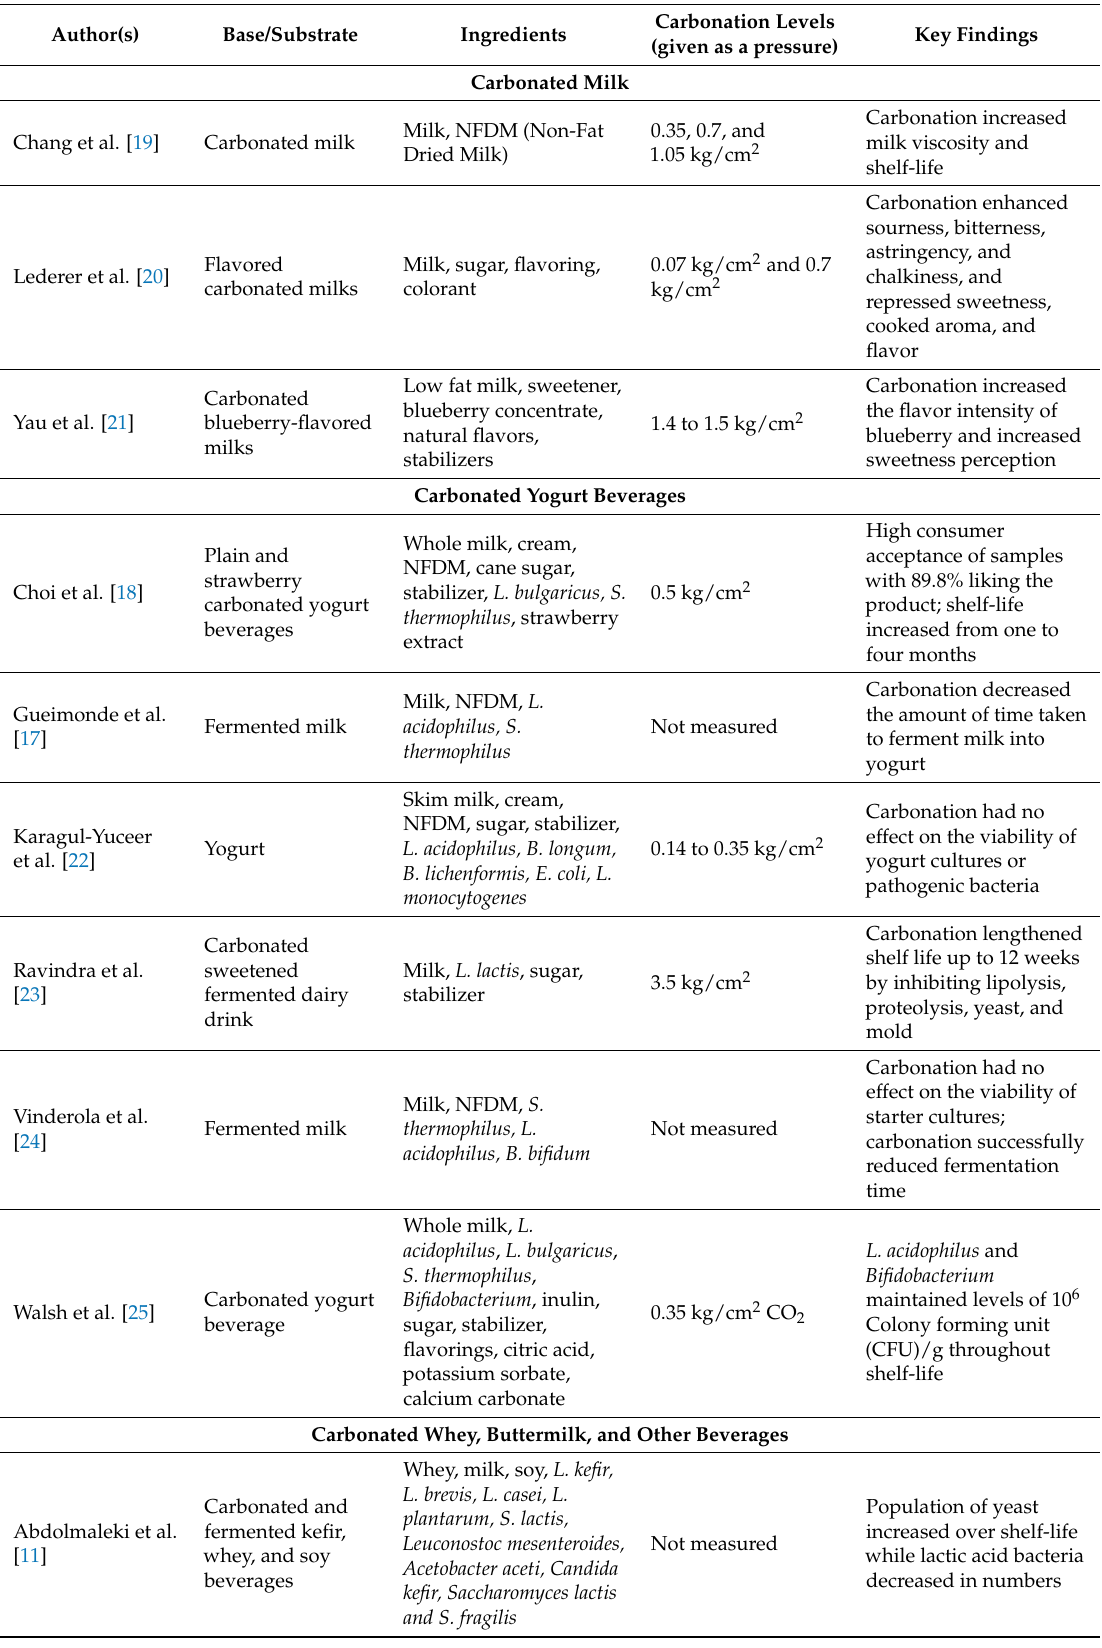
Table 2. Literature on carbonated dairy